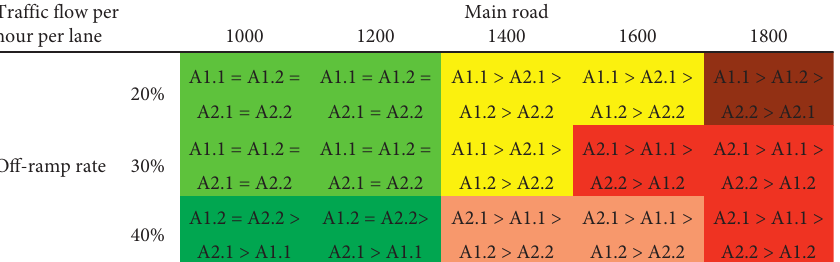
Table 2: The comparative analysis table of four strategies under different traffic flow states.